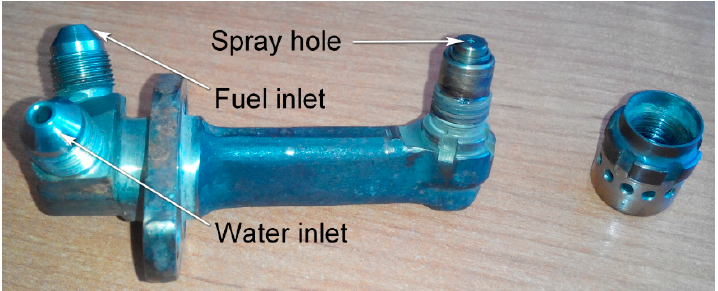
Figure 2. Nozzle for injection of fuel and water into the diesel intake manifold. (Source: Authors).